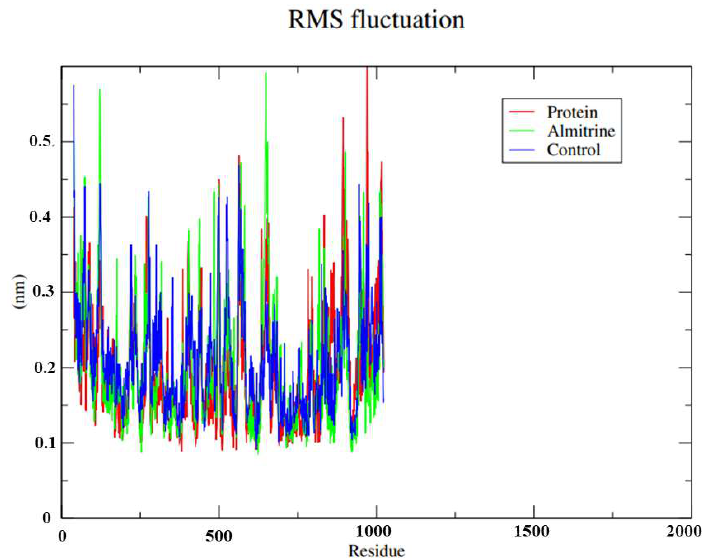
Figure 5. Root-mean-square fluctuation (RMSF) for the C α atoms of the transporting ATPase of H. sapiens alpha 1 complexed with the almitrine and the control thapsigargine. Legend: Green: ATPase of H. sapiens complexed with almitrine; Blue: ATPase of H. sapiens complexed with the control thapsigargine; and Red: H. sapiens transporting ATPase homologous protein.